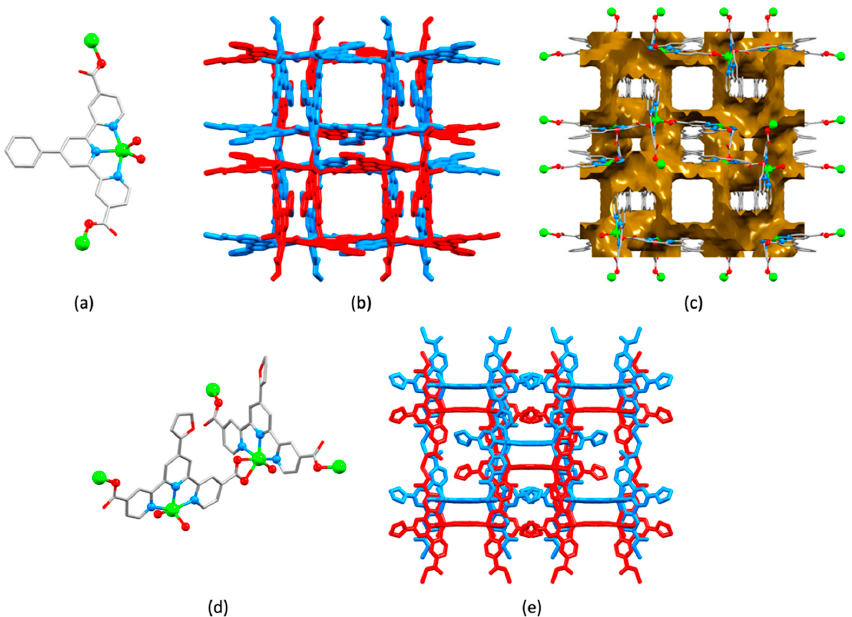
Figure 7. The structure of [Zn( 10 )] n (CSD refcode DECXOB): ( a ) the coordination zinc(II) environment, ( b ) interpenetrating gis-c 3D networks and ( c ) representation of the solvent accessible void-space (drawn using Mercury 2020.3.1 [17]). The structure of [Zn( 11 )] n · 5 n H 2 O (refcode PAFXUS): ( d ) the two independent zinc(II) and ligand environments, and ( e ) interpenetrating sra 3D nets viewed down the crystallographic a -axis.